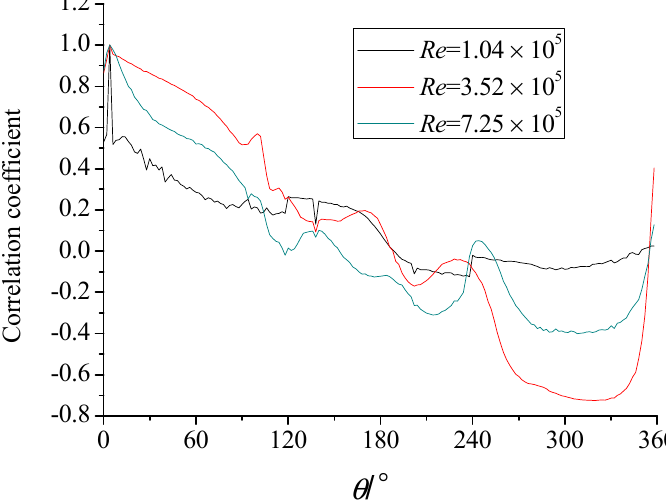
ffi cient at typical Reynolds Figure 21 . The correlation coefficient at typical Reynolds number. Figure 21. The correlation coe